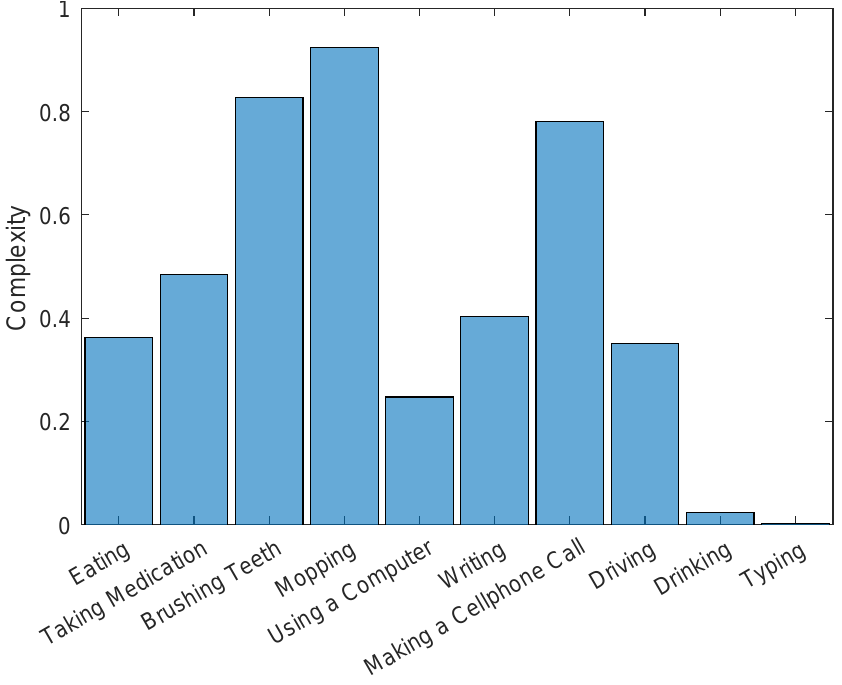
Figure 4. Complexity values normalized by activity